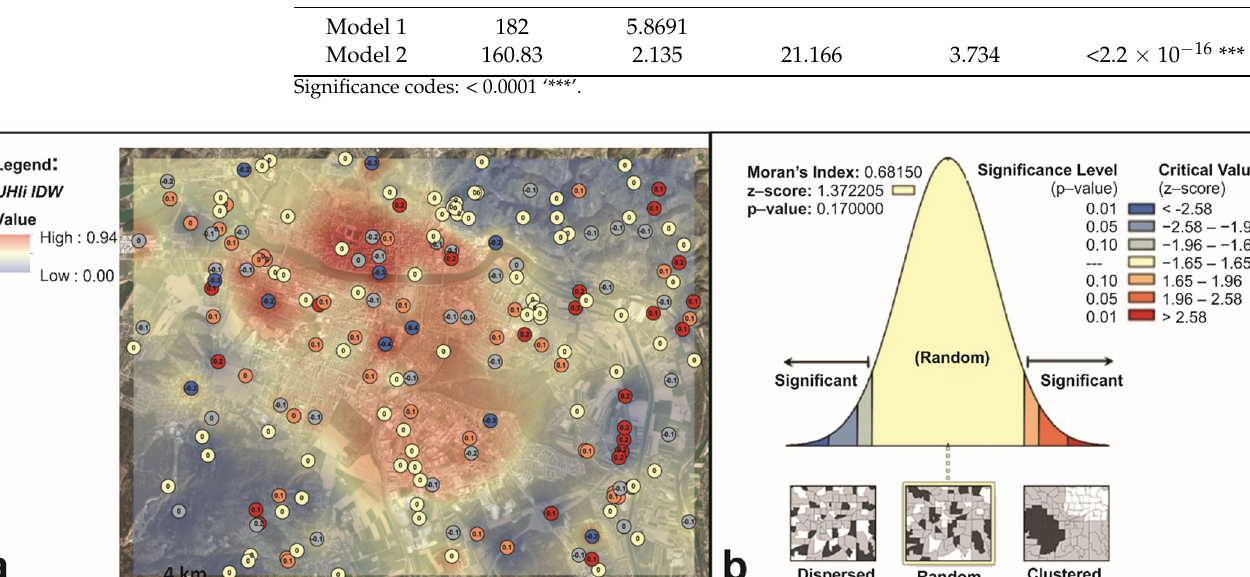
Figure 6. Future UHIi in Maribor. Differences between considered time windows (in °C) per ssp scenario.